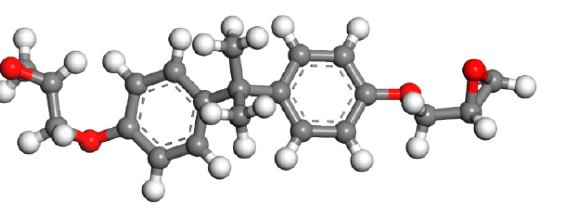
Figure 2. The chemical information of epoxy. Figure 4. The model of MC120D (colour legend: hydrogen H (white); nitrogen N (blue); carbon C (grey)). Figure 5. The model of TEPA (colour legend: hydrogen H (white); nitrogen N (blue); carbon C (grey)). Figure 6. The model of BGE (colour legend: hydrogen H (white); oxygen O (red); carbon C (grey)). Figure 7. The model of epoxy resin cured with MC120D (colour legend: hydrogen H (white); oxygen O (red); carbon C (grey); nitrogen N (blue)).